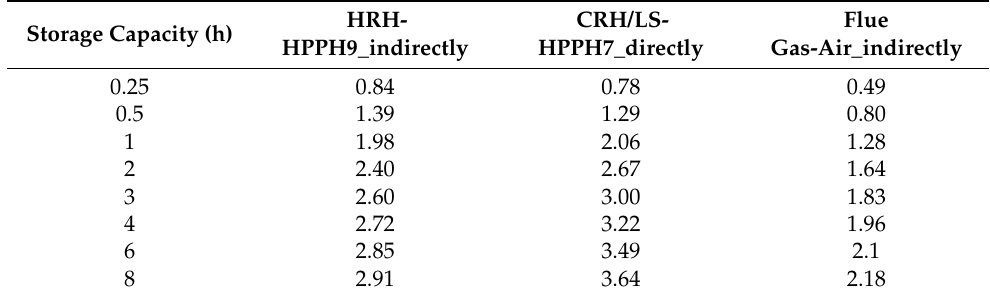
Table 8. Absolute profits in relation to the storage size in million EUR/a (baseline). Storage Capacity (h)